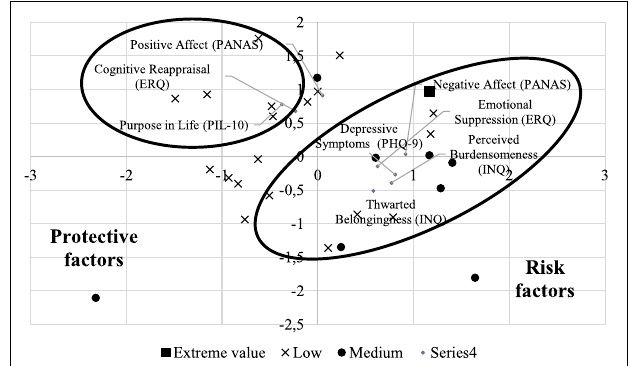
FIGURE 3 | Biplot of factor scores and loadings obtained for participants’ health and strategies and their classification according to the frequency of suicidal